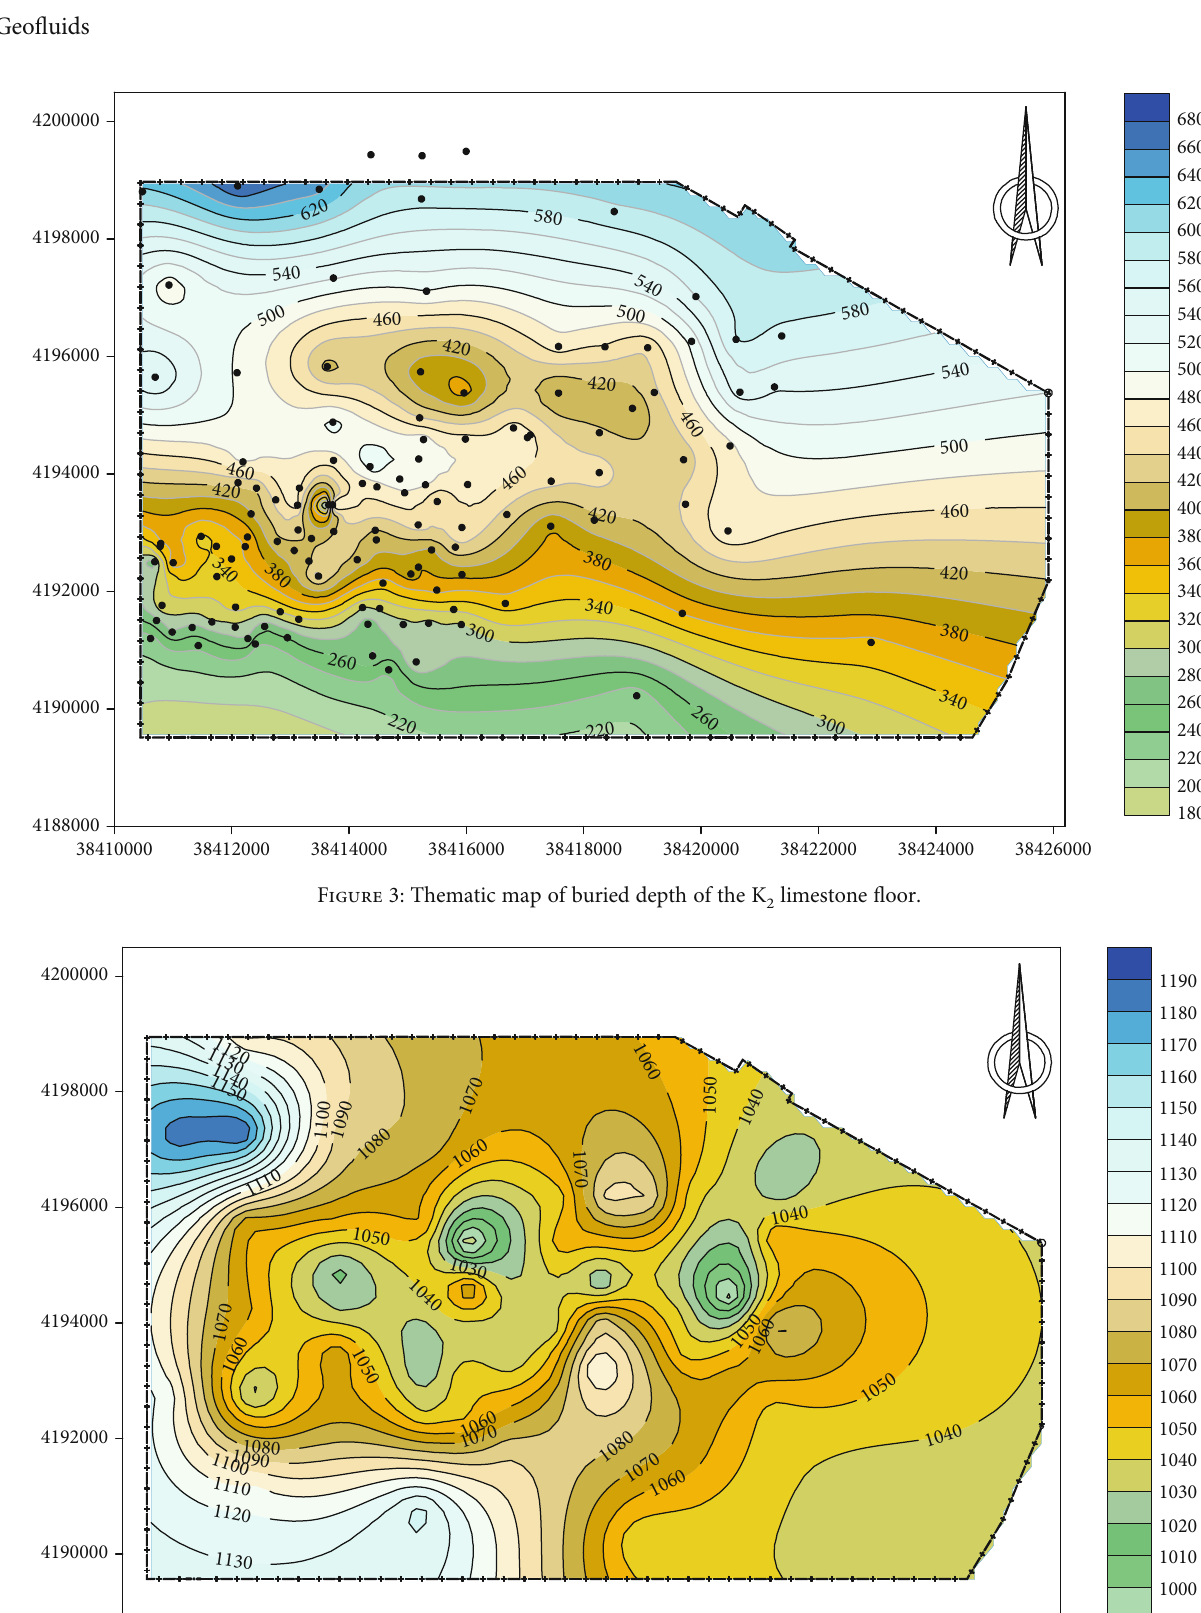
Figure 4: Thematic map of the initial water level of the K